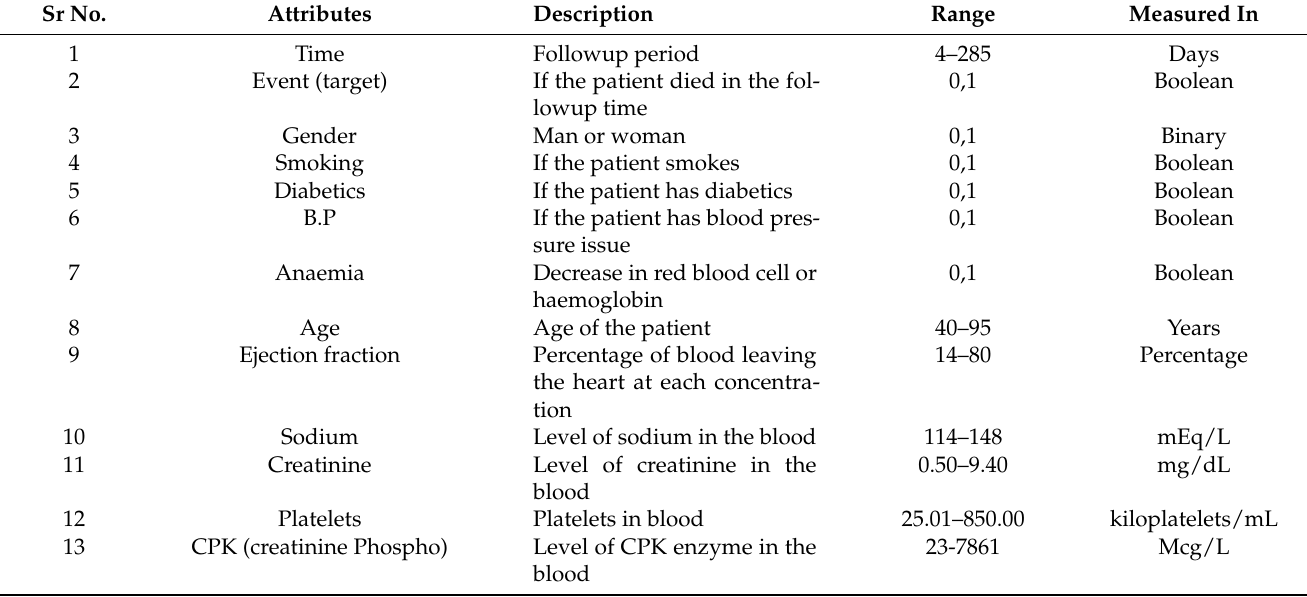
Table 2. Dataset